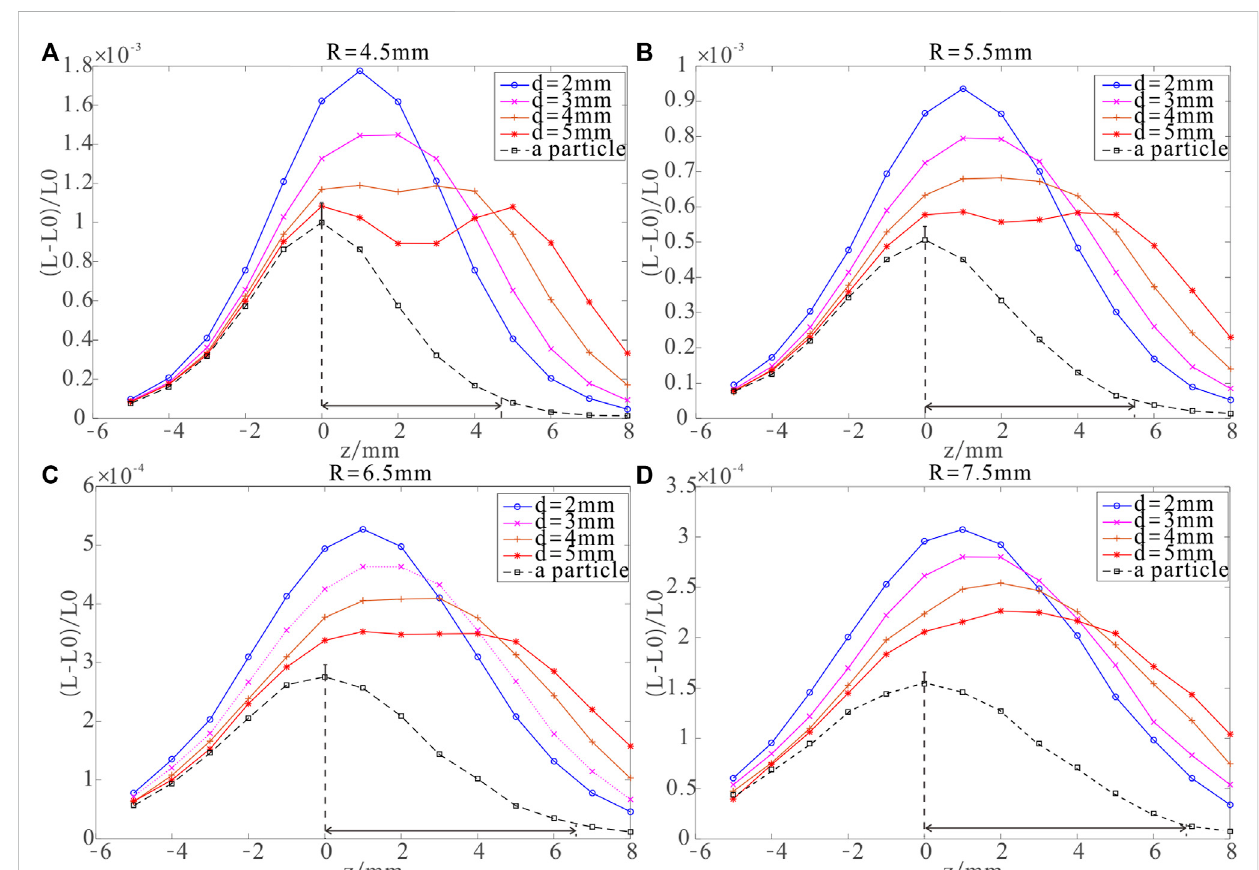
FIGURE 8 In fl uence of variable coil radius R on the coil ’ s signals induced by two adjacent particles on the central axis. (A) R = 4.5 mm, (B) R = 5.5 mm, (C) R = 6.5 mm, (D) R = 7.5 mm.